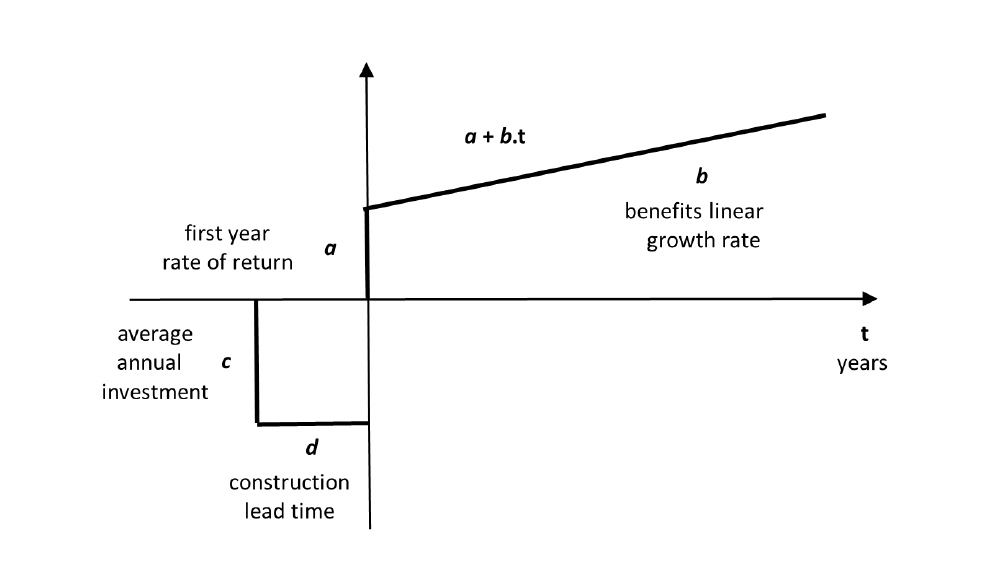
Figure 1. The Cost/Benefit Theoretical Model, or abcd